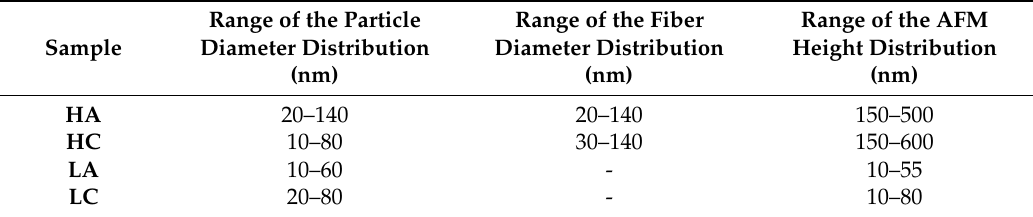
Table 2. Low and high values (range) of the particle and fiber diameter and height distributions evaluated from AFM images.